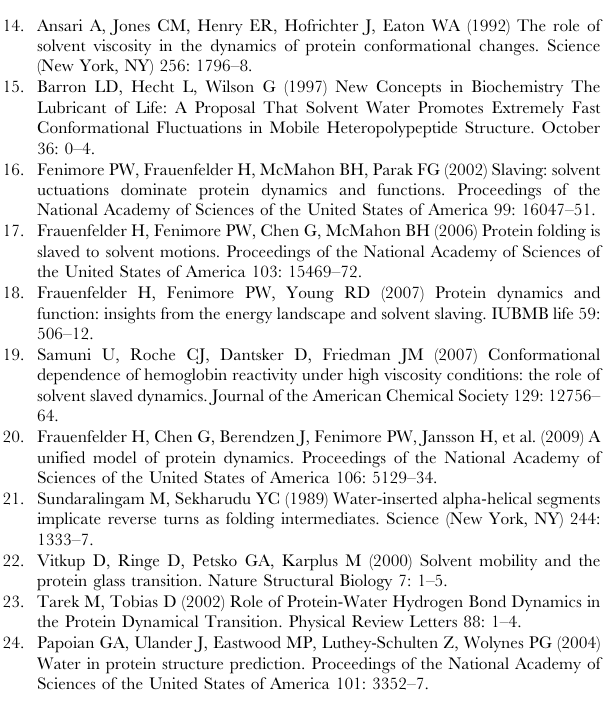
(triangle) for barstar tot